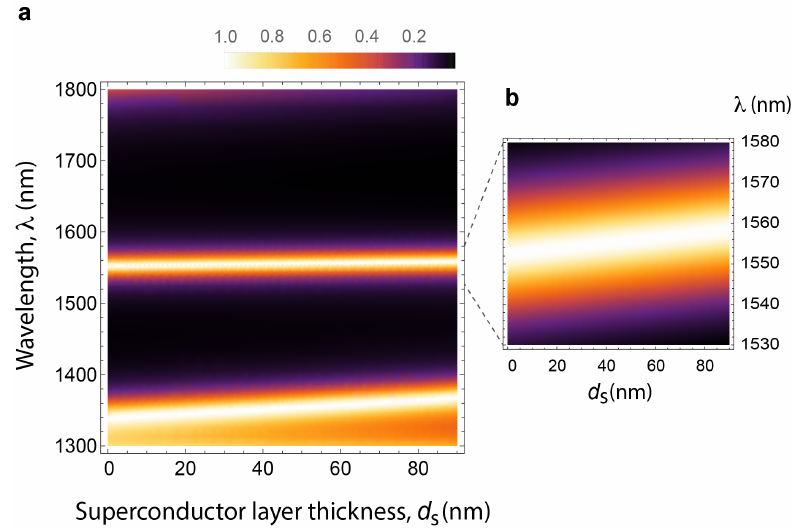
Figure 5. ( a ) Simulated photonic band structure of the ( BTO/Y 2 O 3 ) 5 /YBCO/ ( Y 2 O 3 /BTO ) 5 filter as a function of wavelength and superconductor layer thickness for T = 80 K at normal incidence. ( b ) Filter optical response amplification in the range 1530 nm–1580